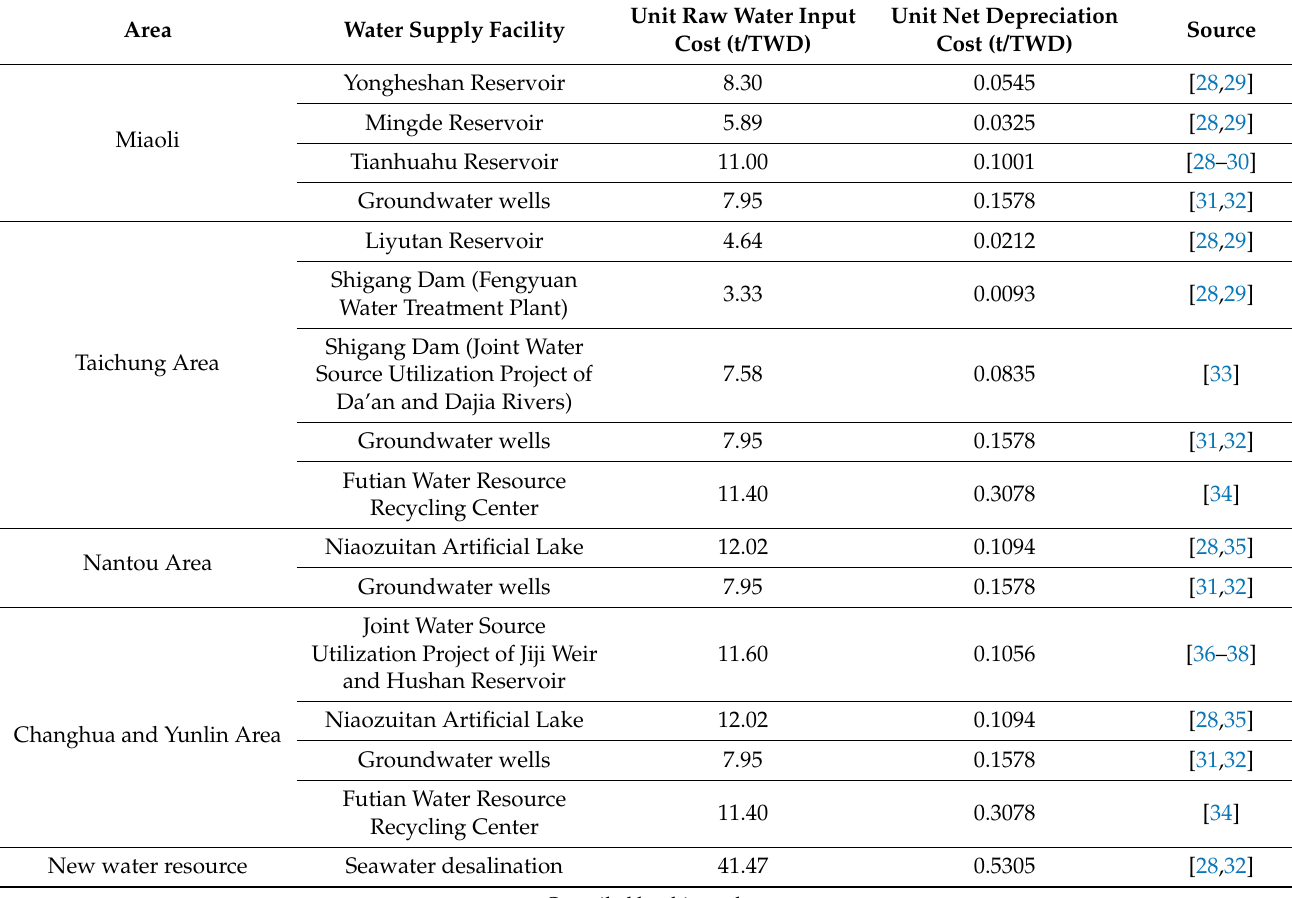
Table 3. Raw Water Input and Net Depreciation Cost of Water Supply Facilities by Area in Central Taiwan.